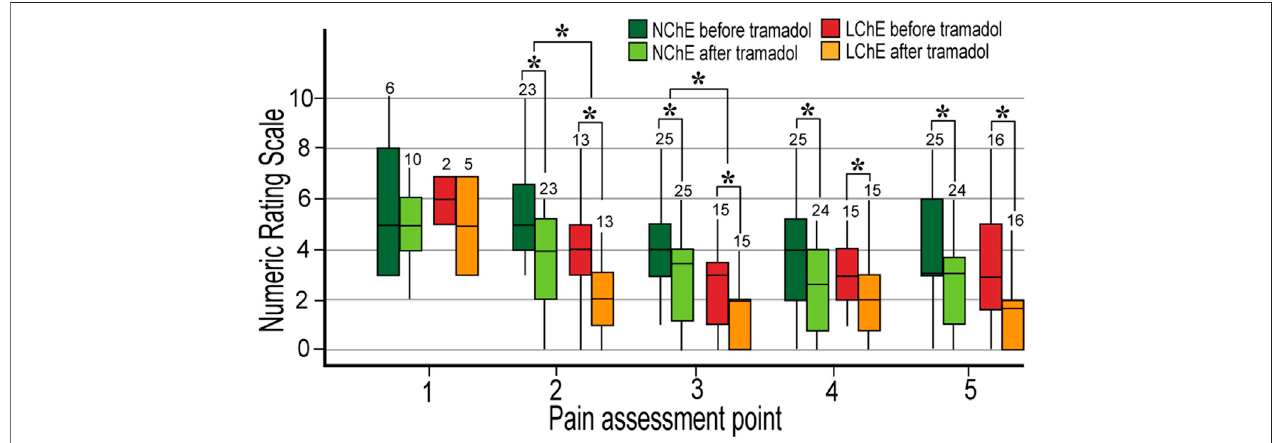
FIGURE 3 | Postoperative pain in the fi rst 24 postoperative hours in the patients with normal and low preoperative plasma cholinesterase activity. Normal metabolizers(EMandIM)wereanalyzed.Thepainwasmeasured fi vetimesin24 h,beforeand30 minafter100 mgoftramadol.Thenumbersofparticipantsarewritten above the boxplot. LChE: cholinesterase ≤ 4244 U L − 1 ; NChE, cholinesterase > 4244 U L − 1 ; NRS, Numeric Rating Scale; *statistically signi fi cant differences in NRS between LChE and NChE group (upper cluster — Mann-Whitney U test) and in NRS before and after tramadol within the samegroup (lower cluster – Wilcoxon